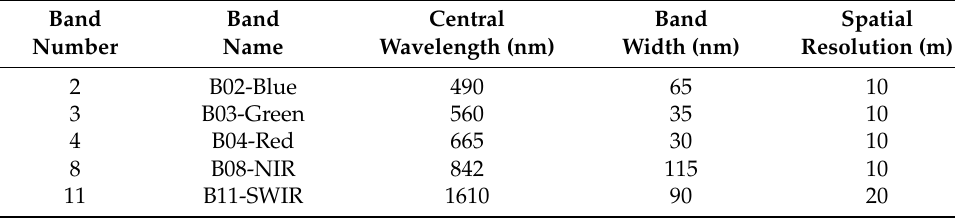
Table 1. Sentinel-2 sensor specifications relevant to this